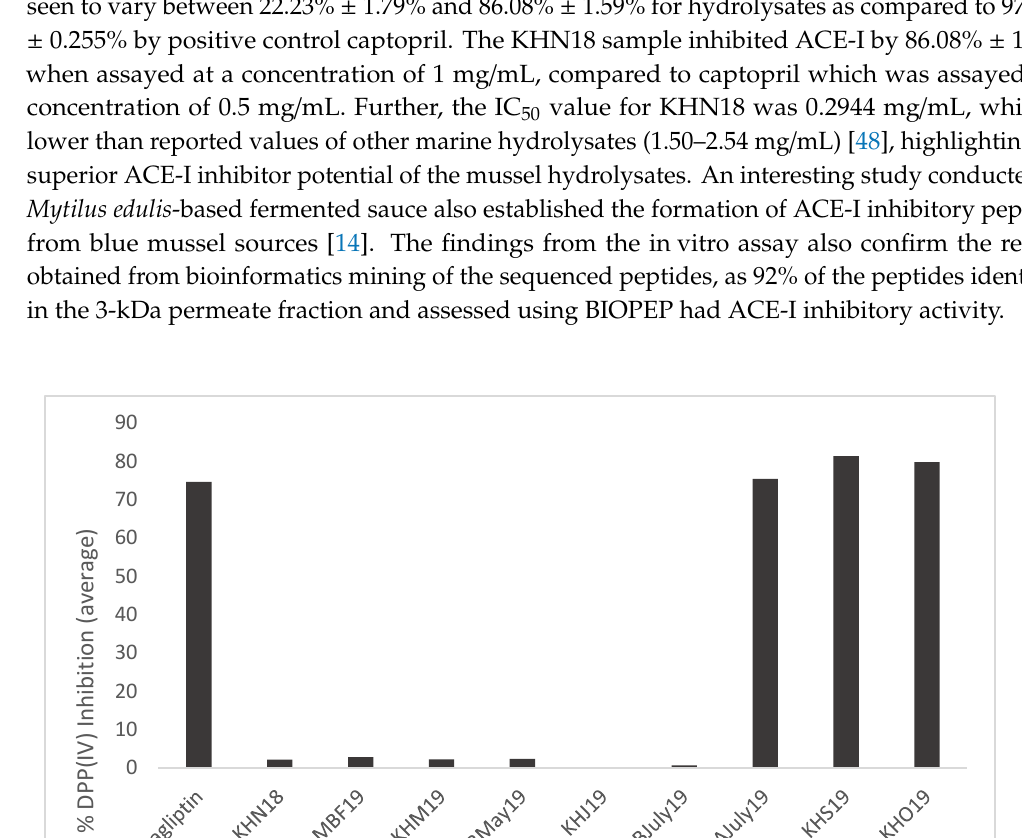
Figure 8. AChE enzyme inhibition (%) by inhibition by mussel Protamex ® hydrolysates. Nine samples from the three sampling sites, Mulroy bay (MB), Killary harbor (KH) and Ardgroom (A), collected from November 2018 to October 2019, were used for analysis at a concentration of 1 mg/mL. *The positive control showed significantly higher AChE inhibition as compared to all the samples. Assays were performed in triplicate (n = 3).